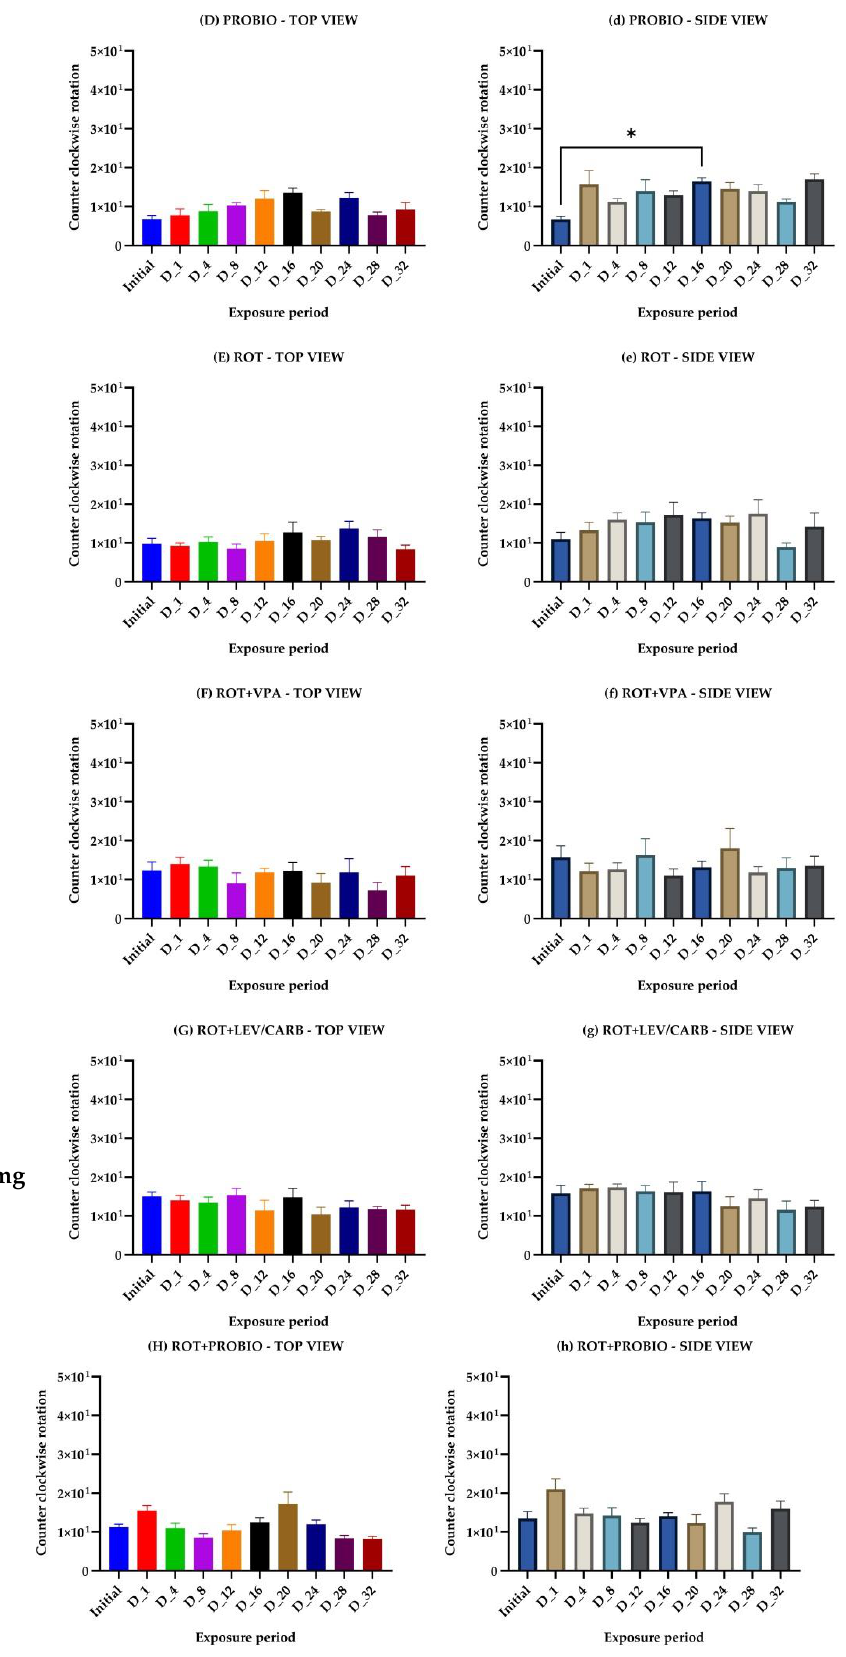
Figure 2. Counterclockwise rotation parameter in Danio rerio (n = 5) studied groups (values expressed as mean with SEM followed by Dunnett’s test; * p < 0.05).